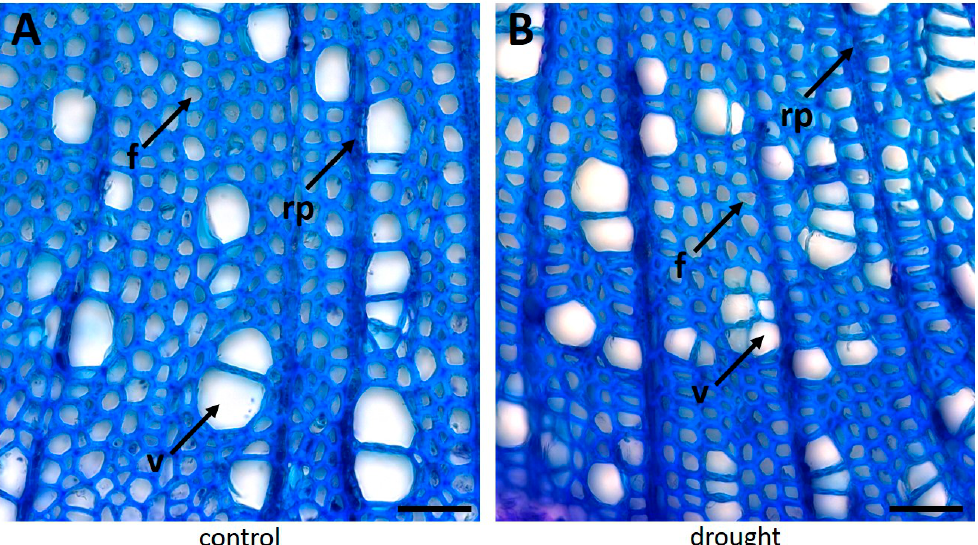
Figure 3. Comparison of non-stressed ( A ) and drought-stressed ( B ) xylem tissue of Populus tremula x tremuloides . B shows vessels with reduced size but increased vessel frequency. v: vessel cells, f: fiber cells, rp: ray parenchyma. Bar = 50 µm.